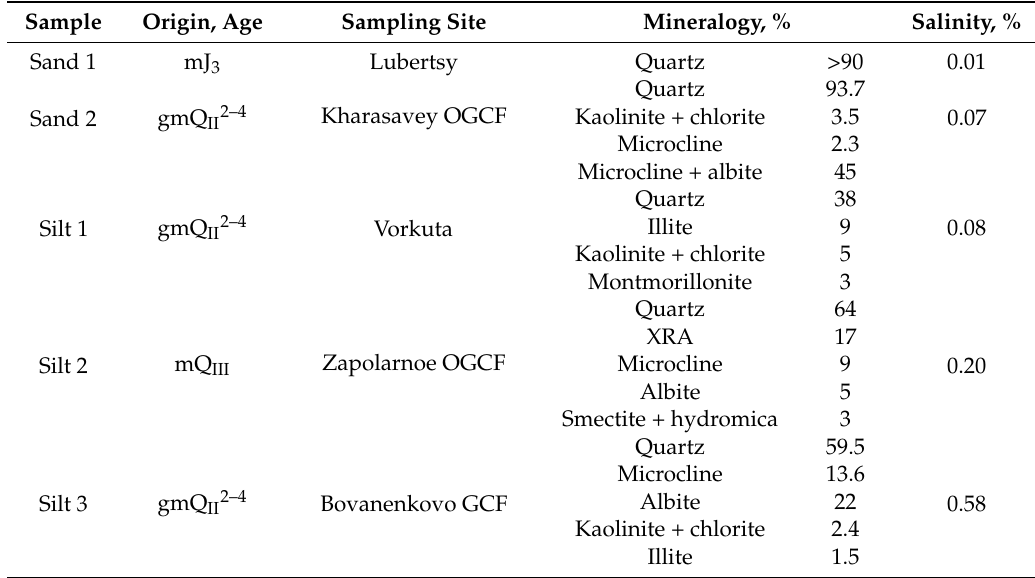
Table 1. Characteristic of investigated